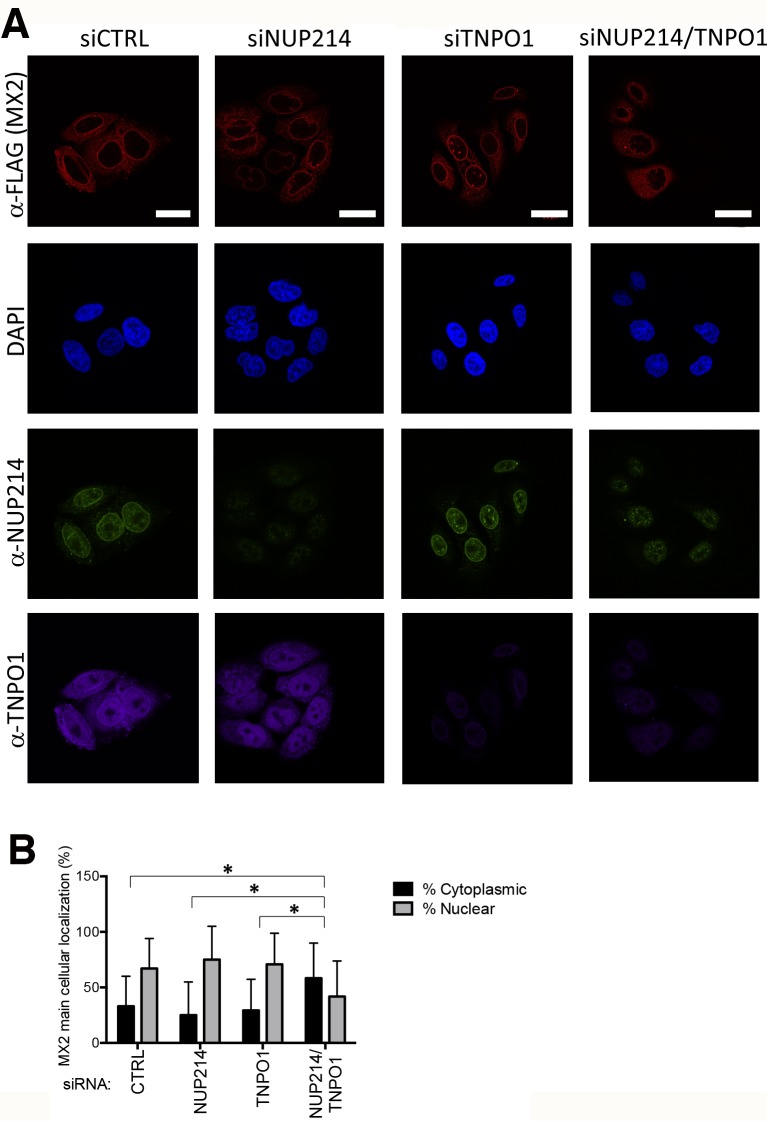
Depletion of NUP214 and TNPO1 disrupts nuclear envelope accumulation of MX2.(A) HeLa cells stably expressing MX2 bearing a C-terminal FLAG tag were transfected with siRNA targeting NUP214 and/or TNPO1 or a non-targeting siRNA (CTRL) as described in Fig 3, and then seeded onto glass coverslips. Localization of MX2, and endogenous NUP214 and TNPO1 was visualized by fluorescence confocal microscopy, using anti-FLAG, anti-NUP214, and anti-TNPO1 antibodies respectively. DAPI was used to stain the nuclei. Scale bar represents 20 μm. (B) Predominant cellular localization of MX2 was determined visually (blinded) using a 60x objective and an average of 100 cells, randomly selected (mean ± SD; *p-value < 0.05; paired t-test).